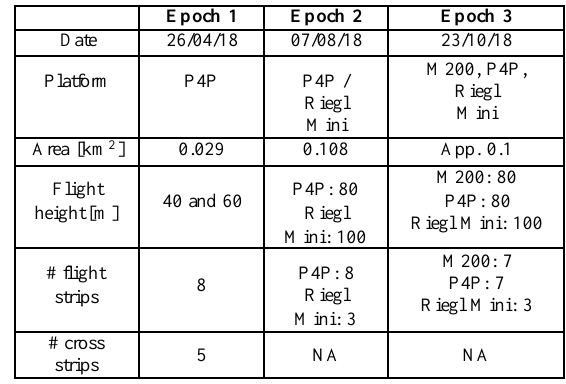
Table 2: Overview of data